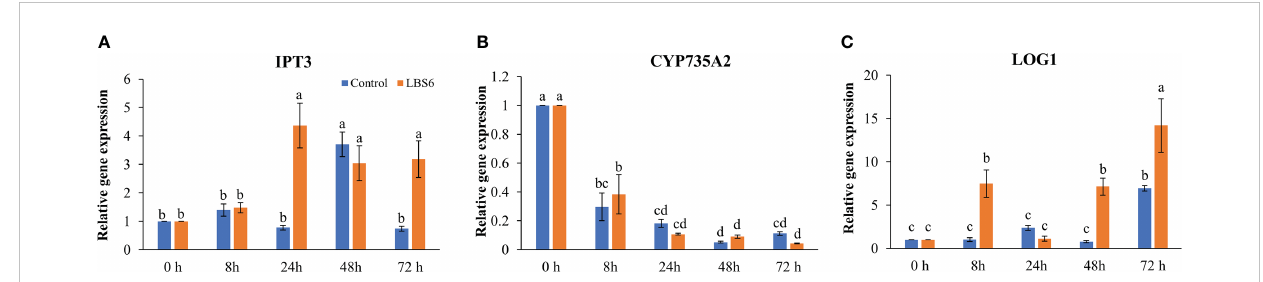
FIGURE 7 LBS6 modulated the expression of (A) IPT3 , (B) CYP735A2 , and (C) LOG1 involved in cytokinin biosynthesis pathways. The values in the graph represents the relative gene expression. The values were presented as mean ± SE of three independent replicates, and signi fi cantly different mean values were represented by different